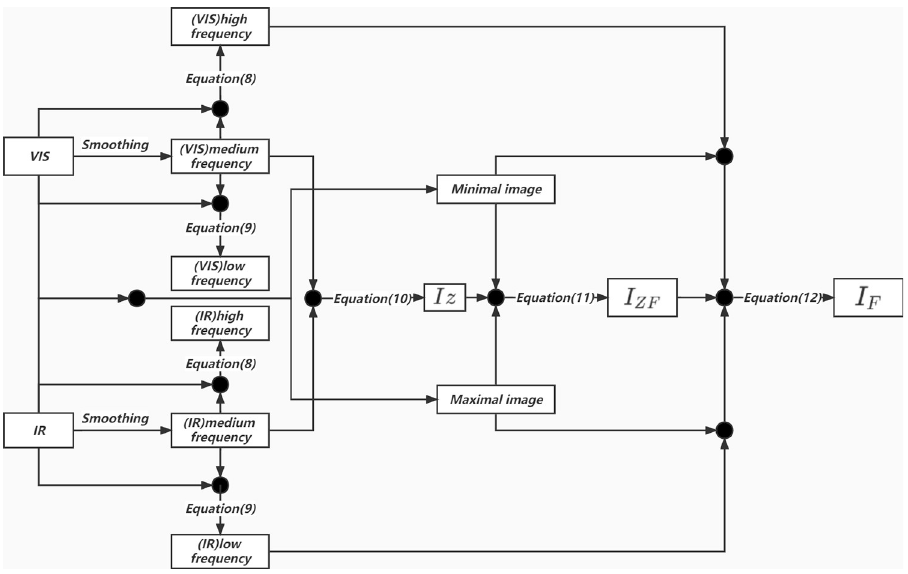
Fig 9. The diagram of the proposed